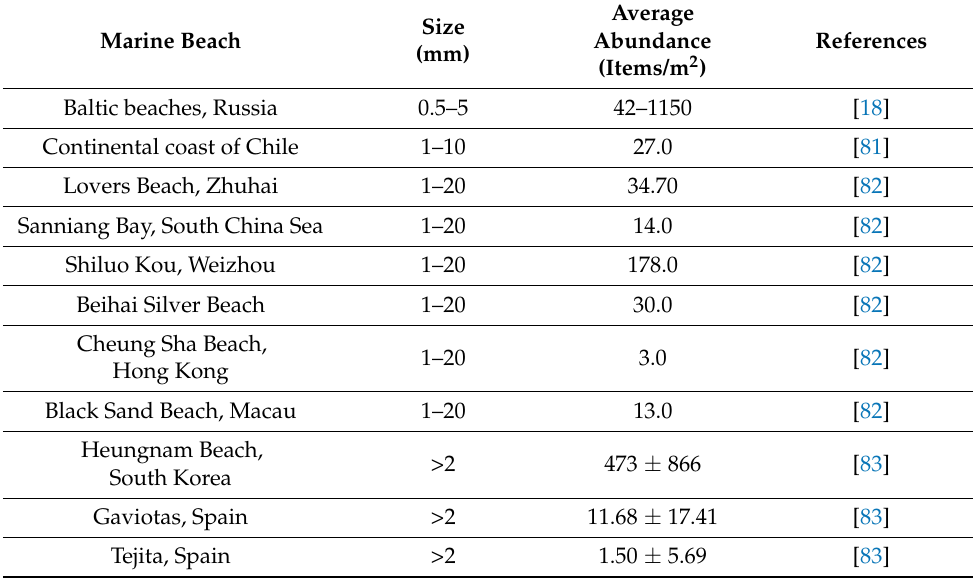
Table 1. Comparison of the abundance of plastic debris on beaches